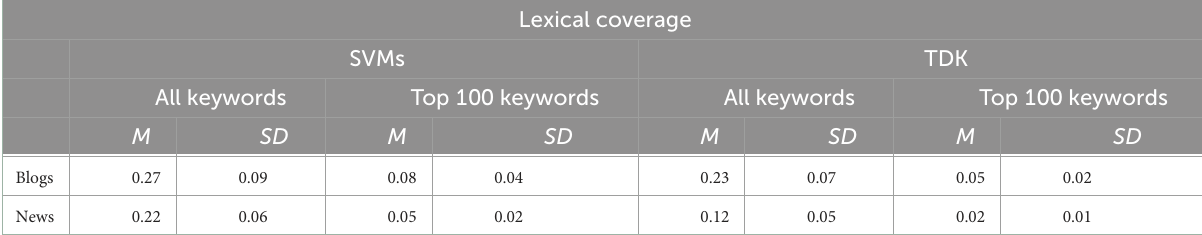
TABLE 9 Lexical coverage of the keywords extracted with SVMs and TDK in the unseen